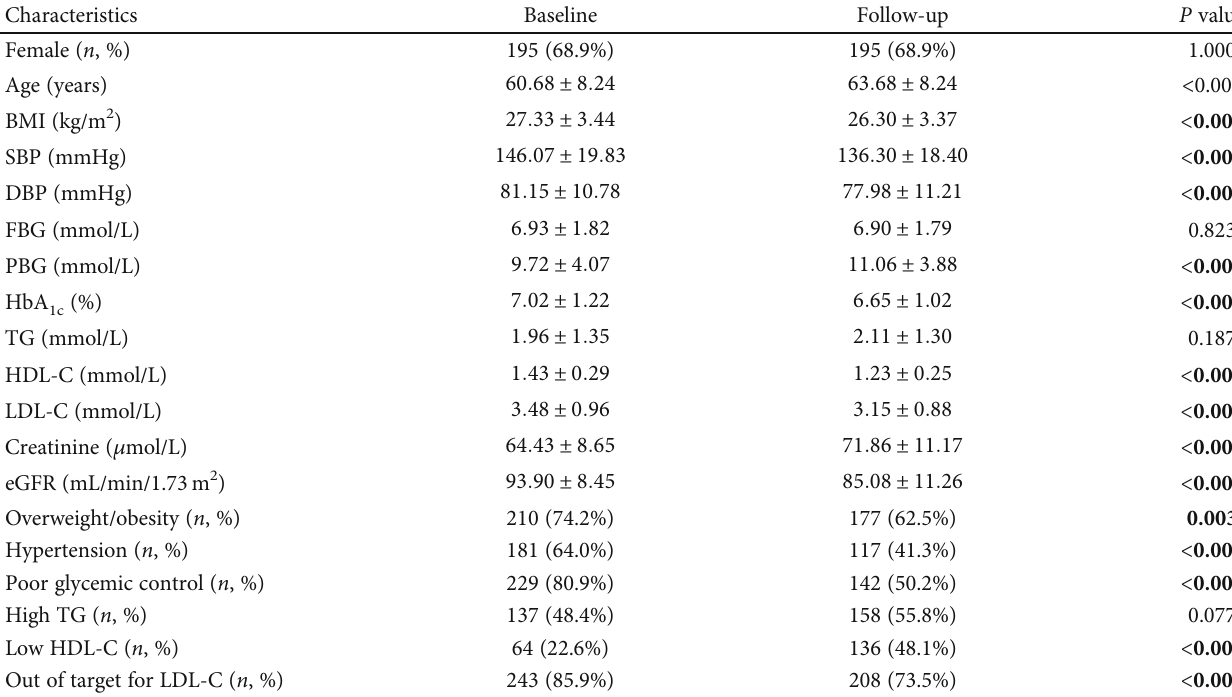
Table 1: Baseline and follow-up characteristics of study